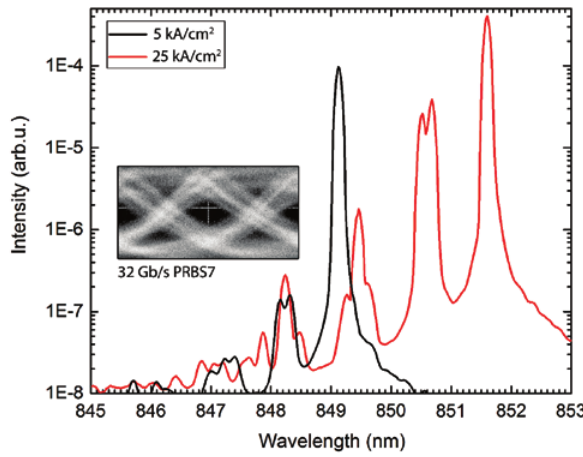
Figure 9: Electroluminescence spectra of an oxide-confined leaky VCSEL with a 5 μ m aperture evidencing the dominance of the funda- mental mode up to high currents (5.5 mA, red). (Insert) An optical eye diagram (PRBS7) at 32 Gb/s.